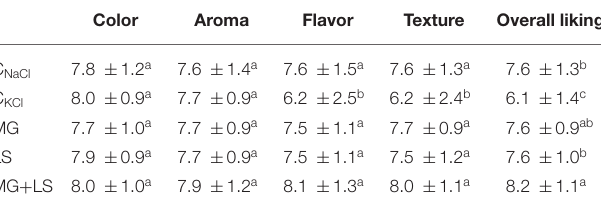
TABLE 6 | Consumer study of prebiotic and low-sodium burgers. Color Aroma Flavor